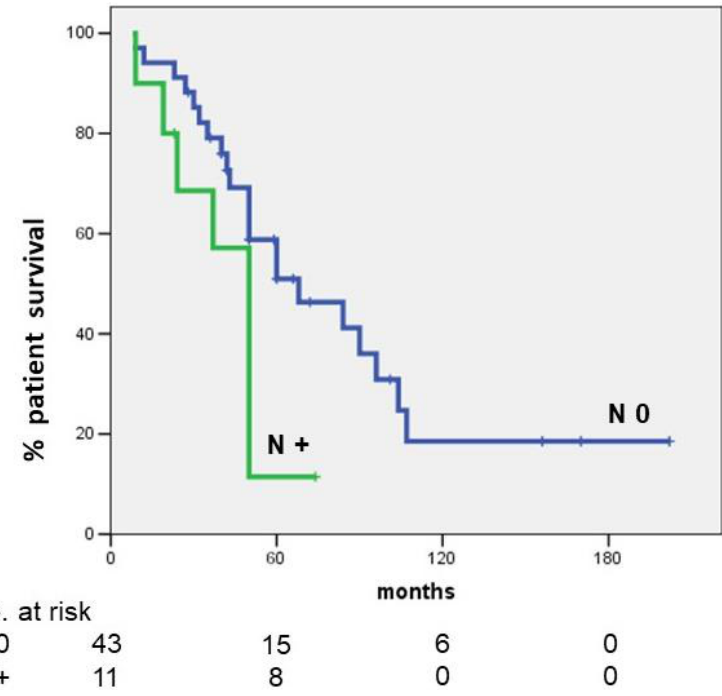
Figure 2. Five-year OS according to the presence of lymph node metastases. Five-year OS in patients with lymph node metastases was significantly lower than that observed in patients without lymph node metastases (11.4 vs. 51.0%, respectively; p = 0.023). Table 6. Association between KRAS mutation status and patients’ characteristics and tumor stage.